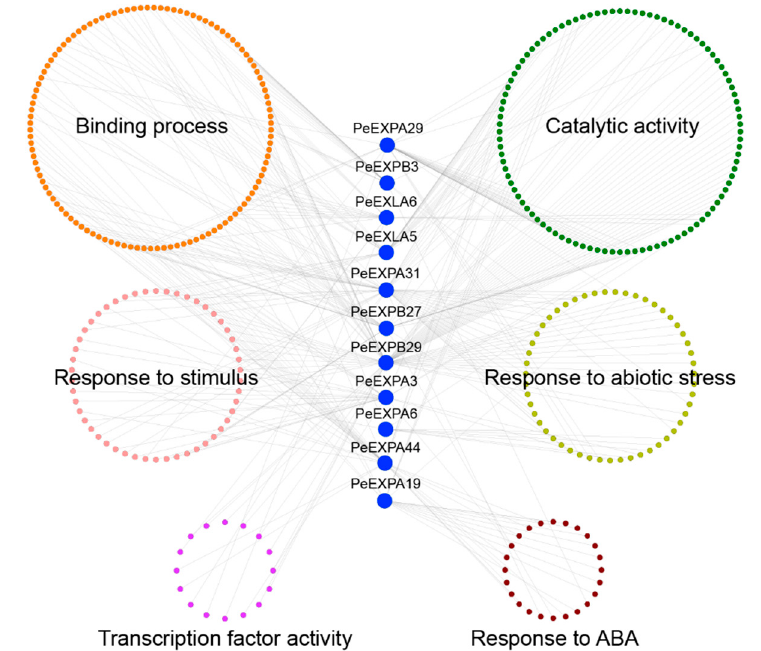
Figure 10. Co-expression regulatory network of expansin genes in moso bamboo. These genes are divided into the following six kinds by GO function annotation in different colors: binding process, catalytic activity, response to stimulus, response to abiotic stress, transcription factor activity and response to ABA.